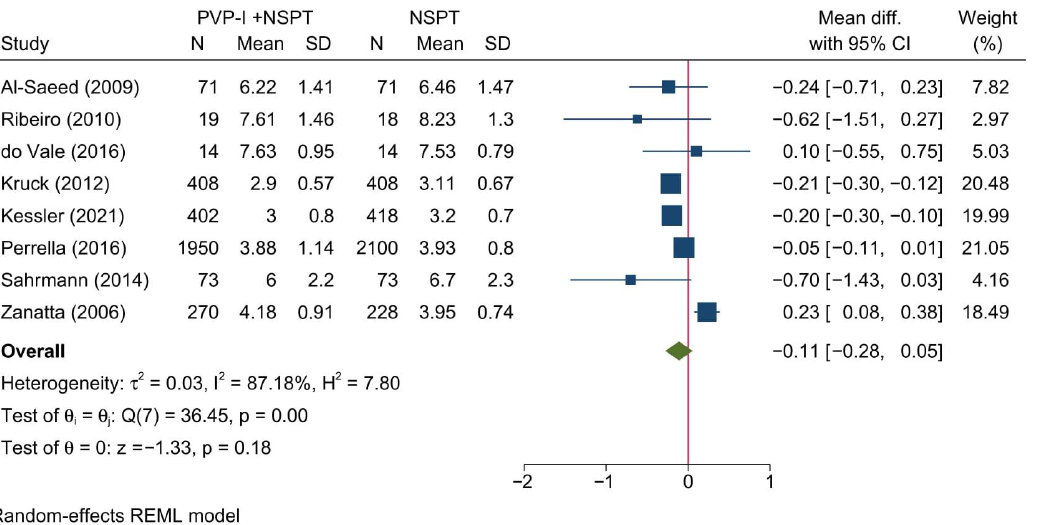
Figure 4. Forest plot showing the comparison between PVP-I + NSPT and NSPT alone regarding clinical attachment level [34,38,40,42–44,46,47].